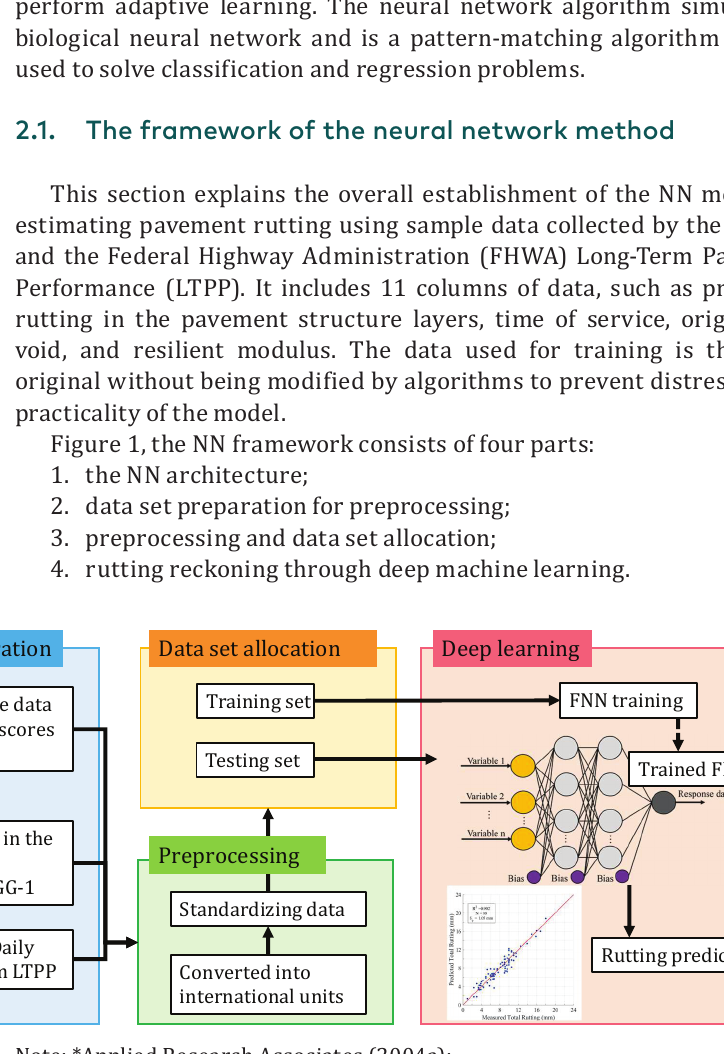
Figure 1. The overall framework of the neural network method